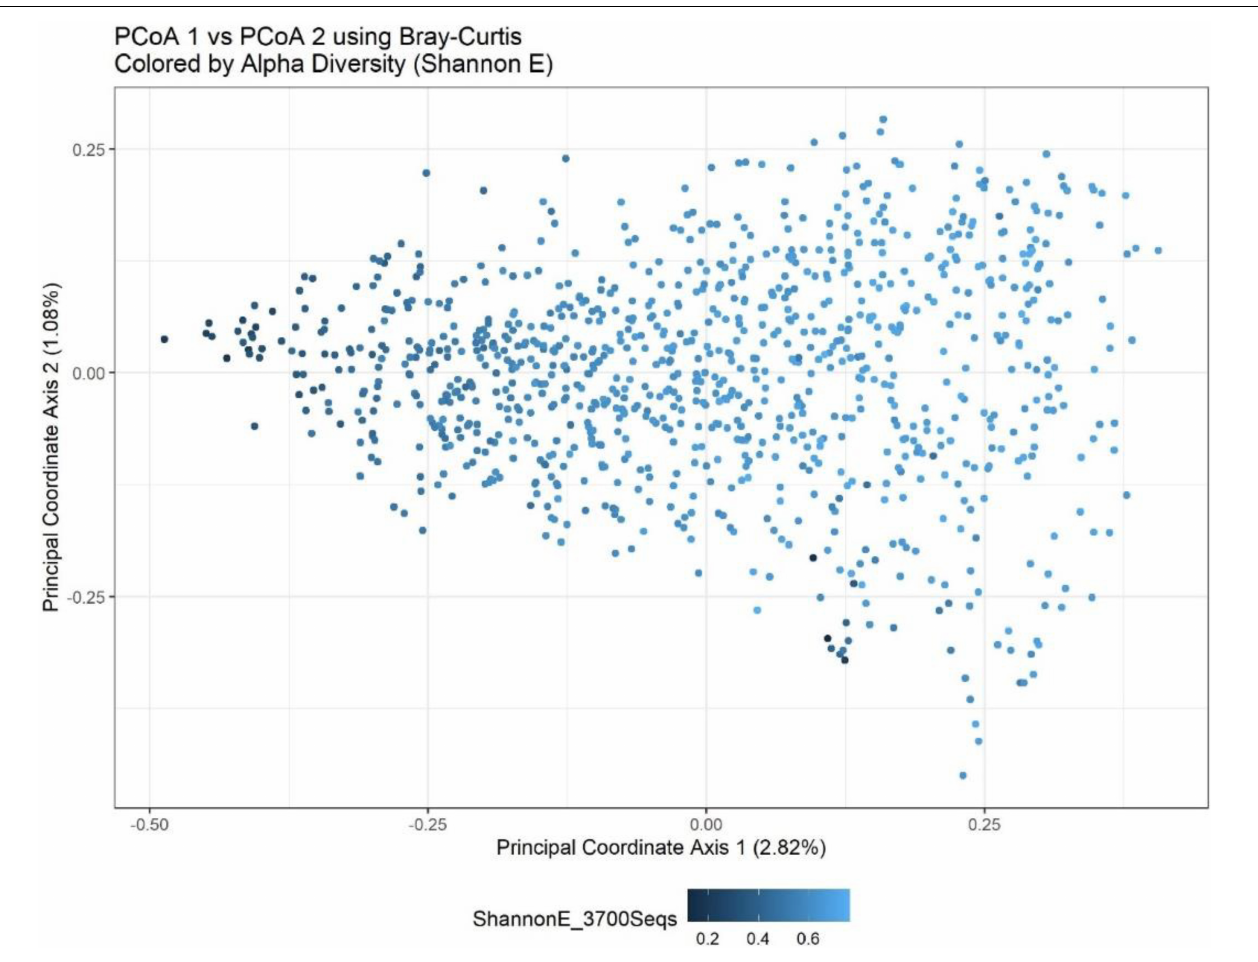
FIGURE 2 | Bray-Curtis PCoA plot of all sites and timepoints colored by Shannon H index. PCoA1 shows a separation of observations based upon a measure of eveness. The percentage of variance explained by each axis is presented in parentheses within the figure legends. Together, the first two components explain